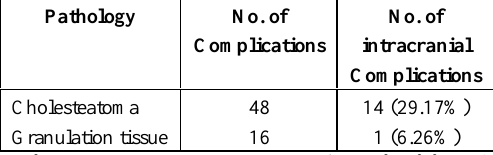
Table V. Comparison of types of pathology with intracranial complication